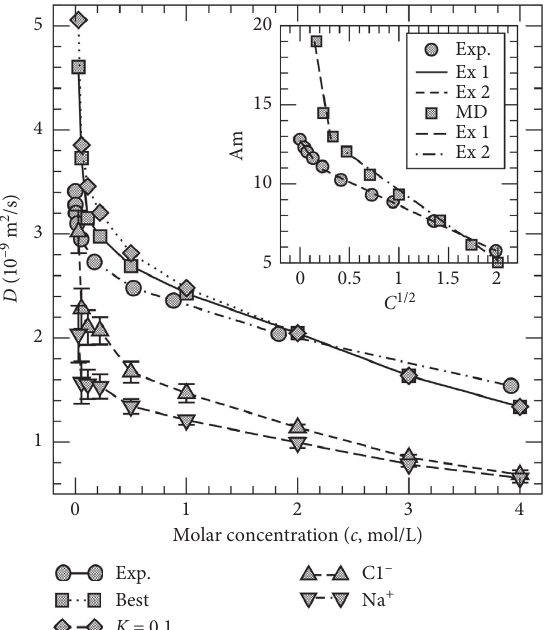
Figure 2: Comparison of the best diffusion coefficients (D), those with κ � 0.10 ˚A-1, and D Na + and D Cl − at 25 ° C as a function of c with the experimental data [23]. The inset shows comparison of molar conductivity ( Λ m) of NaCl as a function of c1/2 obtained from D with the experimental